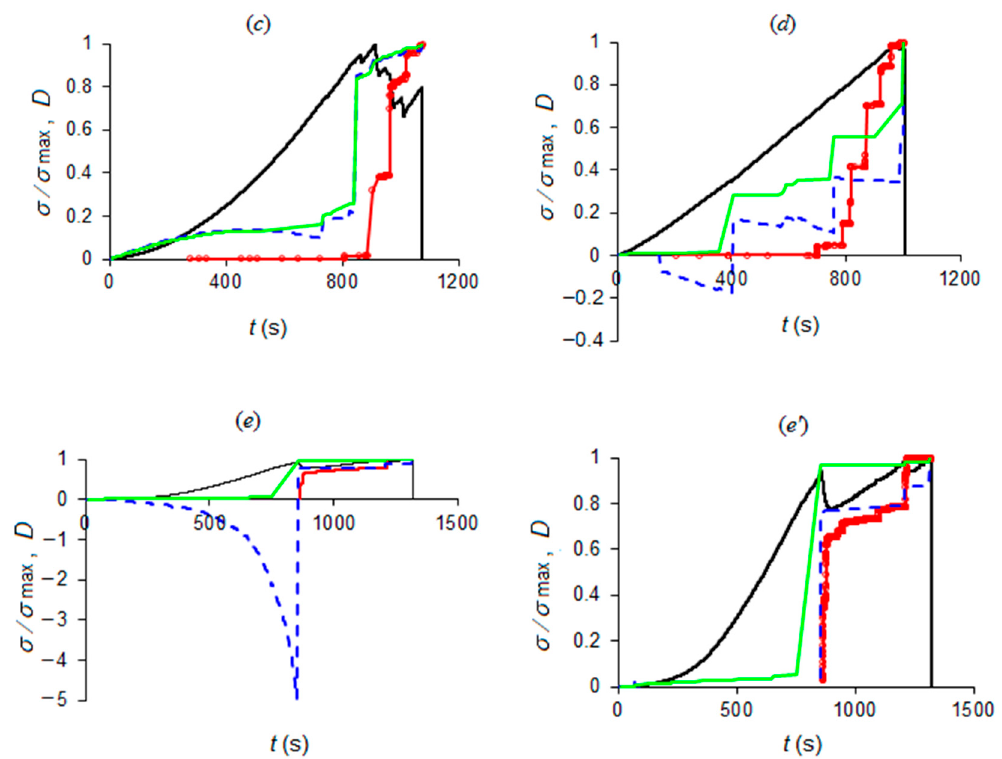
Figure 4. Normalized applied stress (black line) and damage evolution in terms of acoustic emissions (dotted red line); electrical resistance (dashed blue line); and crack surface advancements by indirect measurement (light green line). The diagrams refer to the specimens corresponding to the data presented in ( a – e ) (see inset table of Figure 3). The last picture ( e’ ) is a detail of the positive half-plane (damage D > 0): negative values are due to temporary decrements in the electrical resistance of Luserna specimen ( e ).